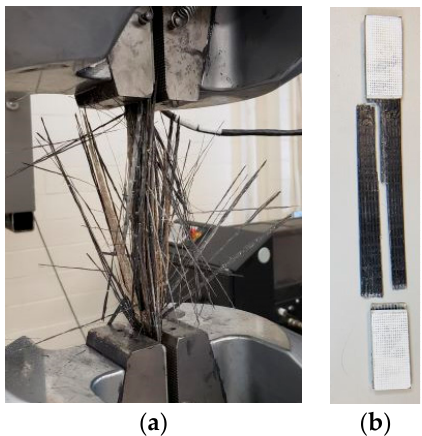
Figure 3. Tensile test curve for inter-ply and intra-ply flax-carbon hybrid composites.